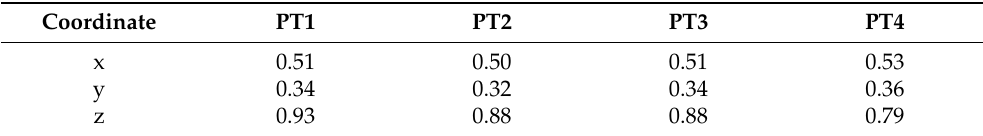
Table 3. RMS of the differences between the estimated displacements and corresponding raw GNSS observations. Units are mm.